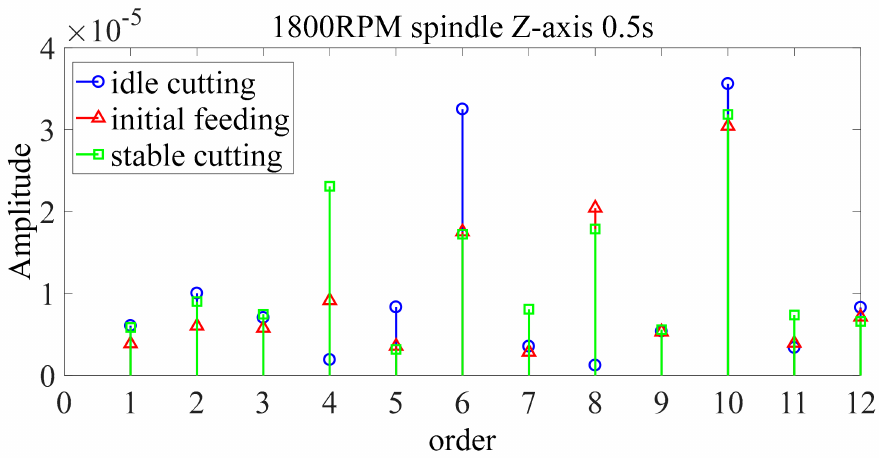
Figure 10. Order spectrum at Z axis at 1800 rpm; complete vibration.